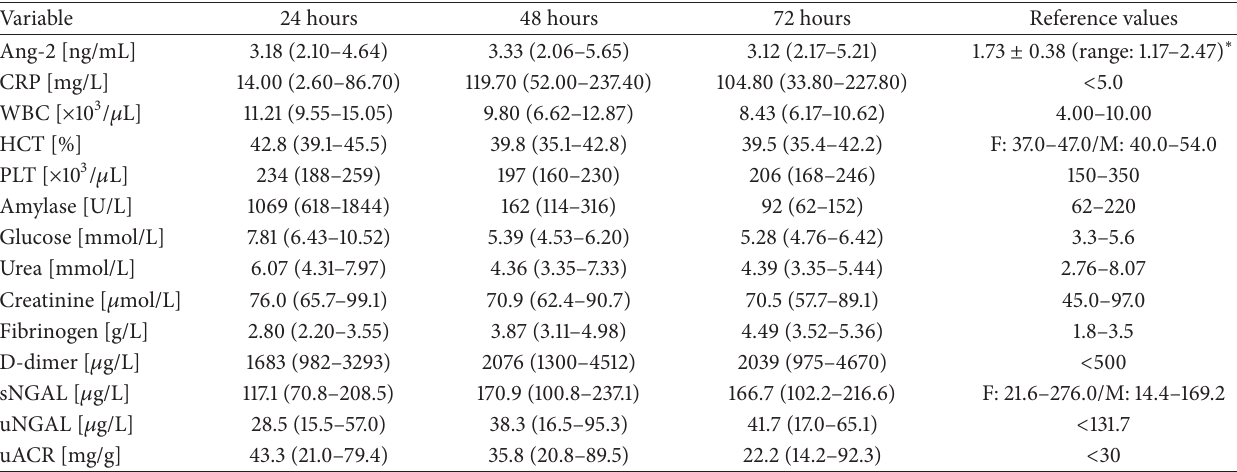
Table 2: Laboratory data in the whole group of patients with acute pancreatitis ( 𝑛 = 65 ).